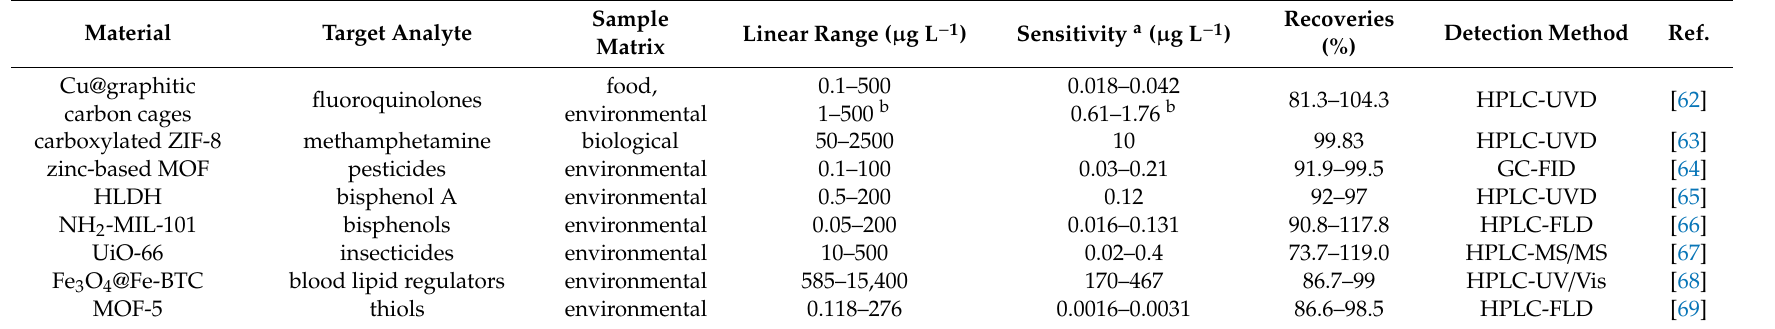
Table 6. Metallic organic framework-based